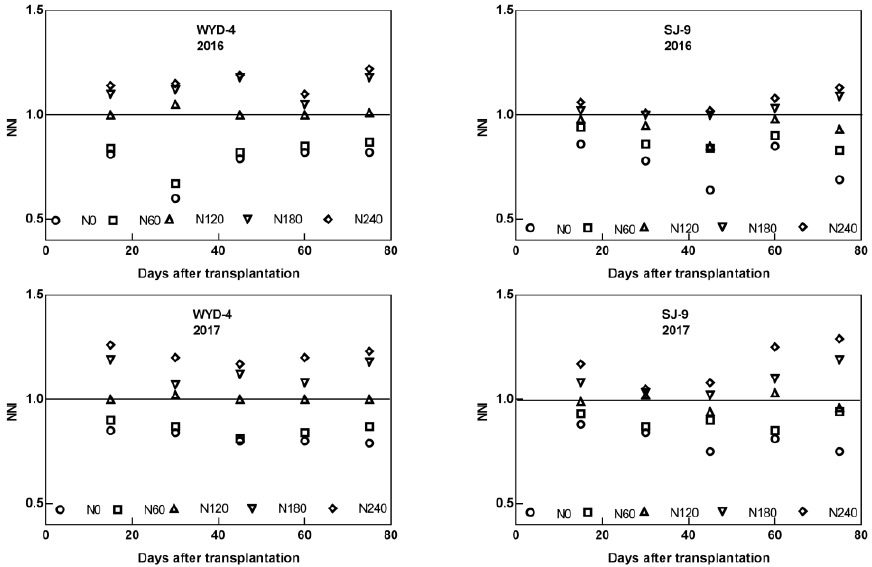
Figure 7. Changes of nitrogen nutrition index (NNI) with time (days after transplanting) for rice under different N application rates in experiments conducted during 2016 and 2017.